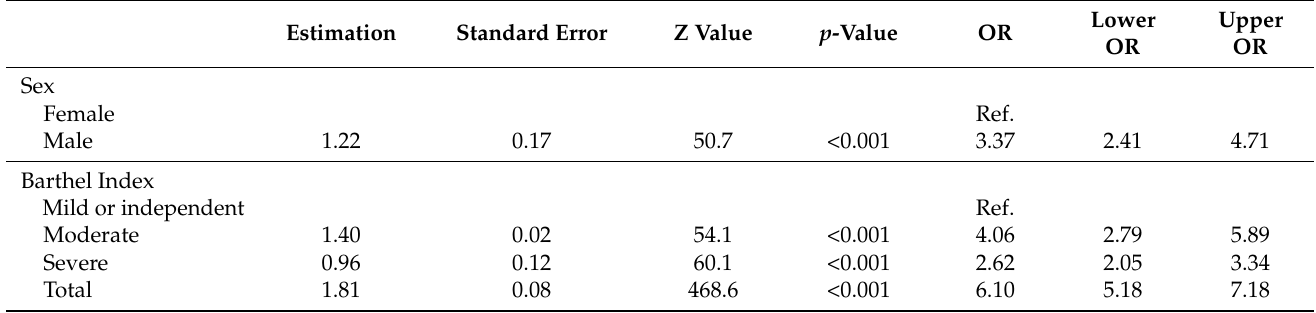
Table 4. Multivariate model of factors related to mortality by SARS-CoV-2: